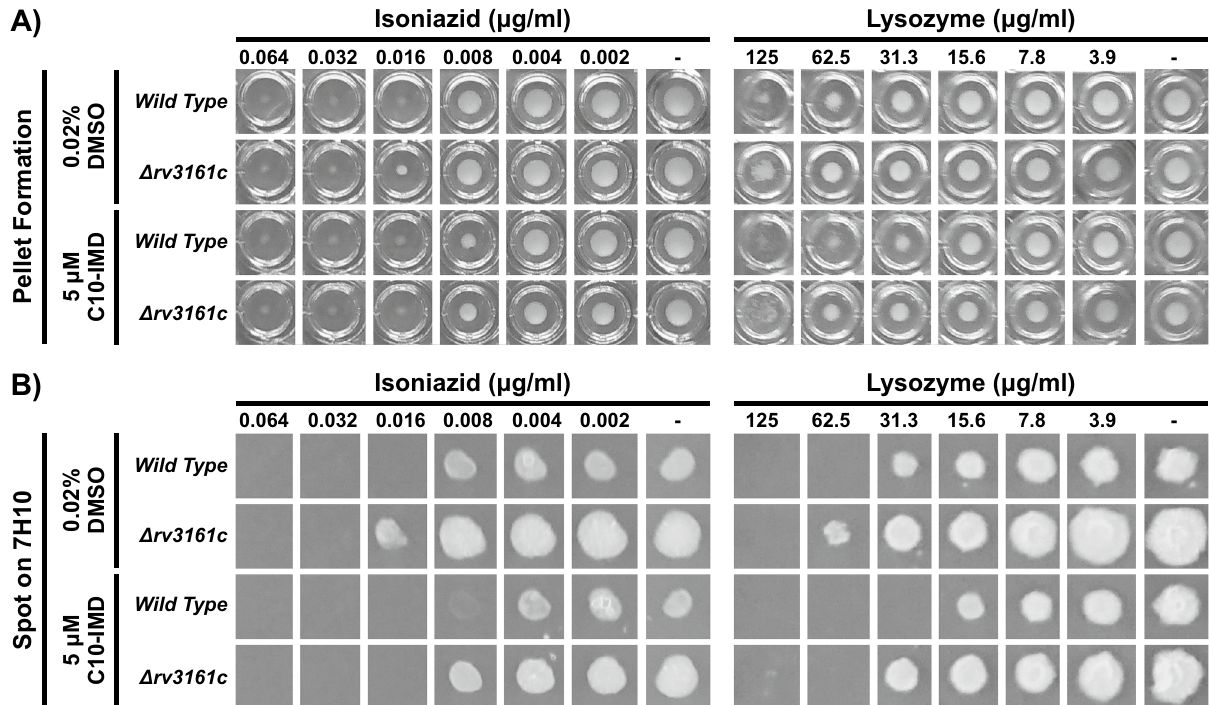
Figure 5. Deletion of the rv3161c gene results in higher resistance to isoniazid and lysozyme. ( A ) Representative images showing effect of INH and lysozyme on bacterial growth scored by pellet formation. Mtb Erdman WT and ∆rv3161c strains were incubated 2 weeks in Sauton’s medium with 0.02% DMSO or 5 µM C10-IMD in addition to various concentration of INH (left; 0.002–0.064 µg/ml) or lysozyme (right; 3.9–125 µg/ ml). ( B ) Representative images showing effect of INH and lysozyme treatment on bacterial survival scored by spotting bacteria exposed to INH (left; 0.002–0.064 µg/ml) or lysozyme (right; 3.9–125 µg/ml) in the presence